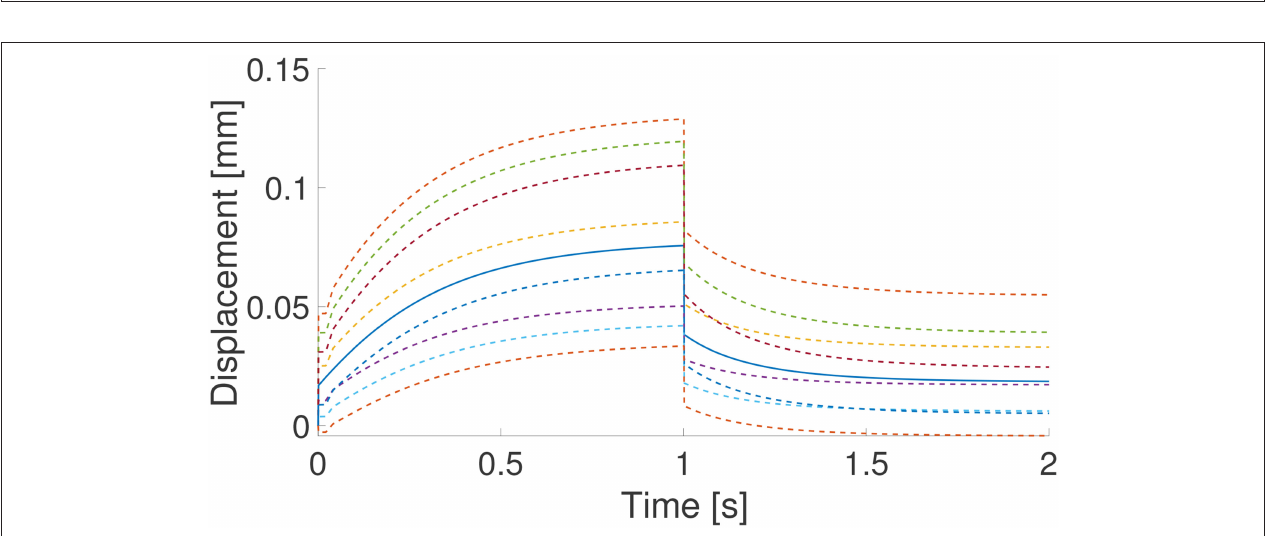
FIGURE 7 | Result (continuous line) of the interpolation on the constitutive manifold of the eight neighboring experimental results (in dashed line). These are the time history of the eight neighboring points in Figure 6 .